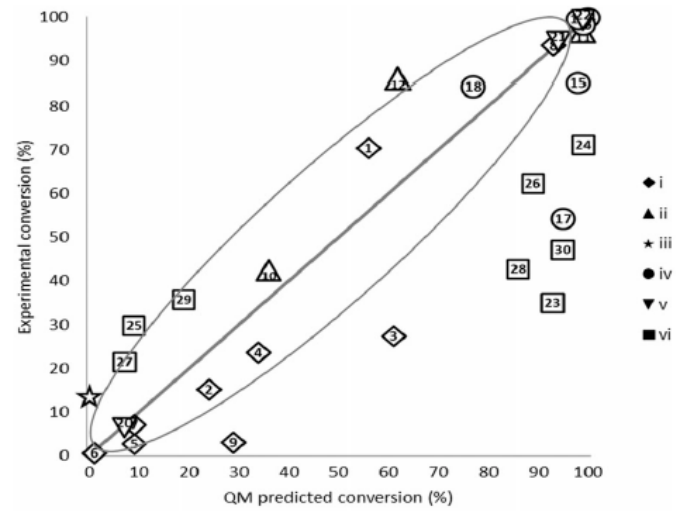
Figure 3. Comparison of predicted and measured transaminase catalysed conversions. For further details see the text and Reference [34].